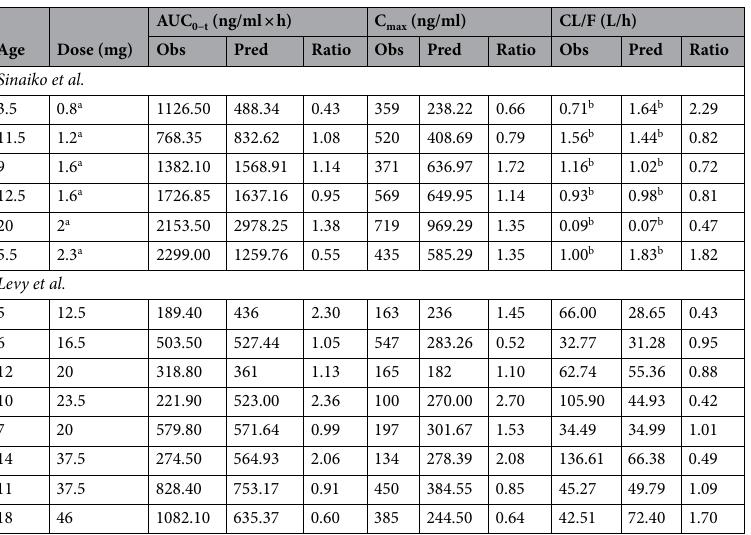
Table 2. Ratio pred/obs of PK parameters in the pediatric population after oral administration of captopril 40,41 . The area under the concentration–time curve (AUC), maximum systemic concentration (C max ), oral Clearance (CL/F), Observed (Obs), Predicted (Pred). a Dose unit in mg/kg. b Clearance units in L/h/kg.